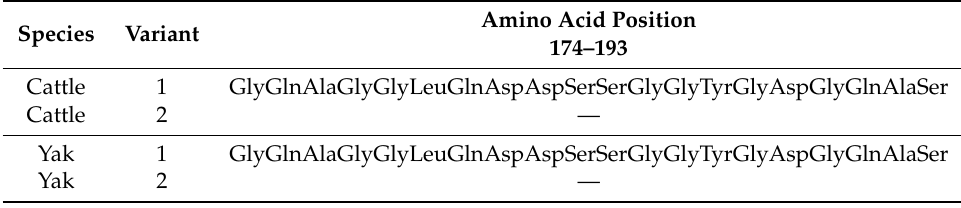
Amino Acid Position